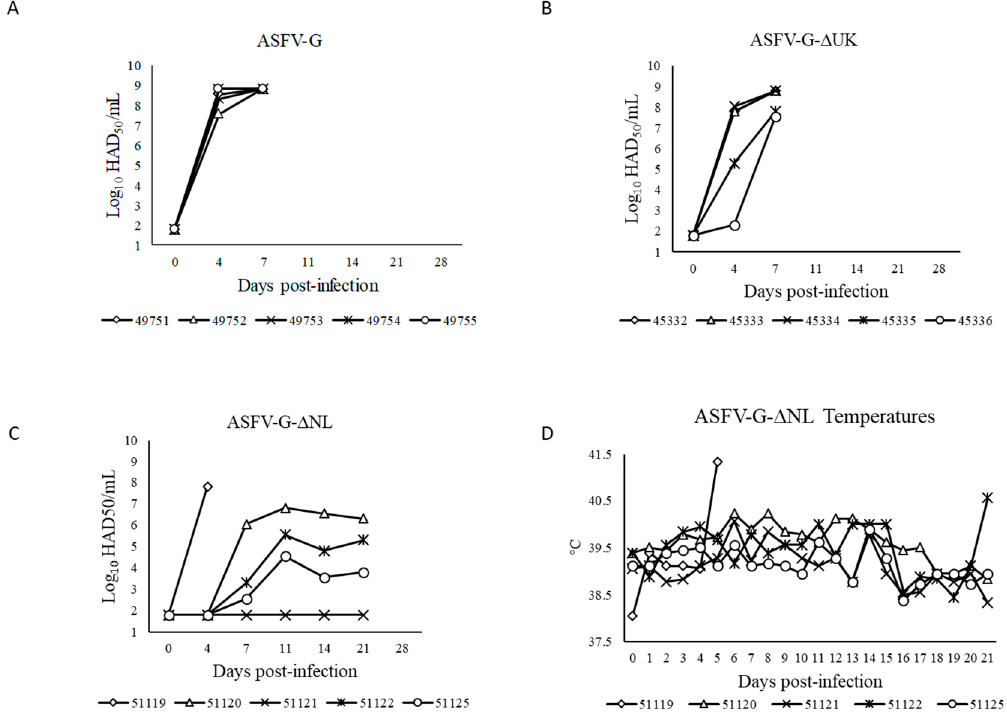
Figure 5. Virus titers in blood samples obtained from pigs infected with either 10 4 HAD 50 of parental ASFV-G ( A ), recombinant viruses ASFV-G- Δ UK ( B ), and ASFV-G- Δ NL ( C ). Values are expressed as log 10 HAD 50 / mL. Sensitivity of virus detection: ≥ 10 1.8 HAD 50 / mL. ( D ) Evolution of body temperature in pigs inoculated with ASFV-G- Δ NL.